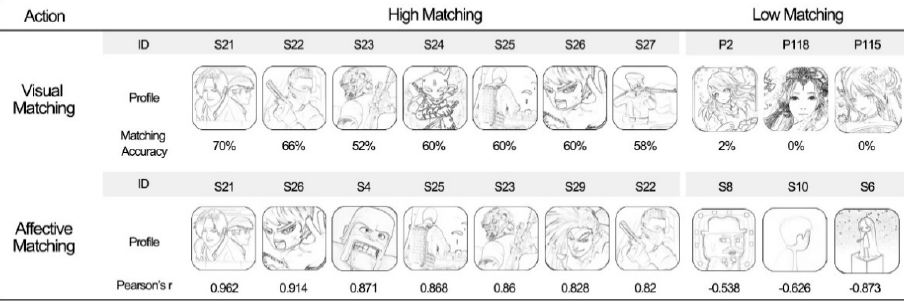
Figure 8. Adventure game icons with high perceptual matching. 4.3.5. Simulation Games Figure 9 shows the perceived matching degree for simulated business game icons. The match rates of icons with a high visual matching icon ranged from 62% to 88%, and